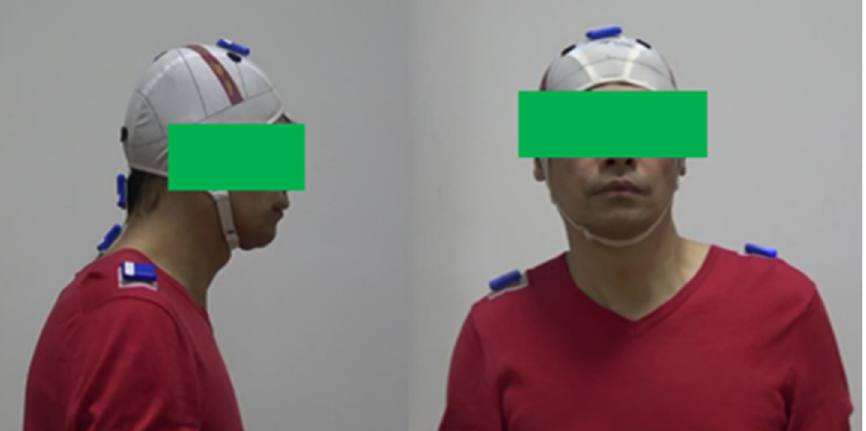
Figure 2. Head positioning